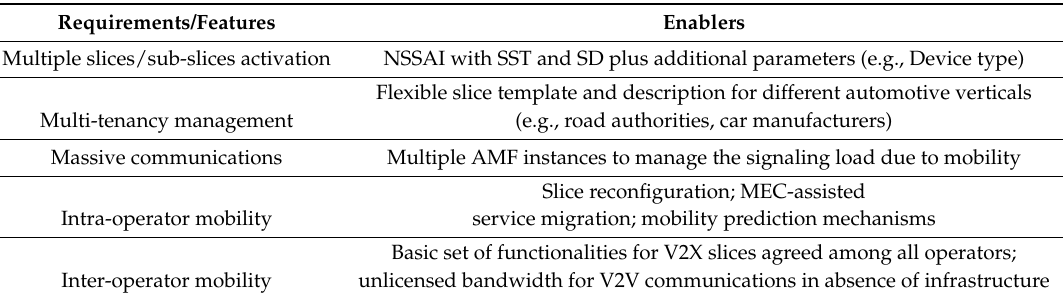
Table 1. Requirements and enablers for V2X network